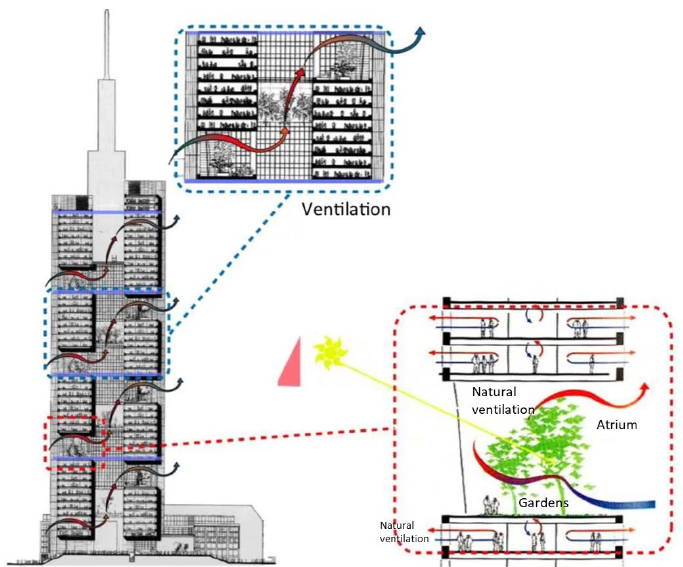
Figure 3. Commercial bank building in Frankfurt designed by Norman Foster. Adapted from available online: http://cmiserver.mit.edu/natvent/Europe/commerzbank.htm (accessed on 1 July 2013) [23].